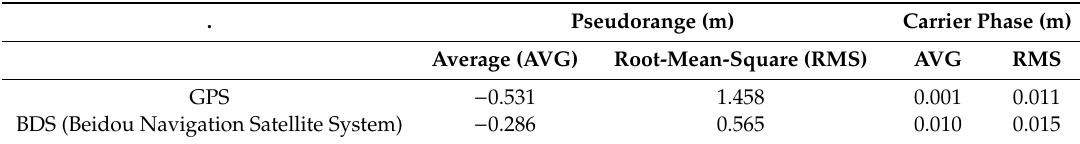
Figure 3. Time series of double-di ff erence residual error for the pseudorange and carrier phase. ( a ) time series of double-di ff erence residual error for pseudorange (top). ( b ) time series of double-di ff erence residual of carrier phase (bottom). Table 4. Characteristics of Global Satellite Navigation System (GNSS) measurement error for short baseline.